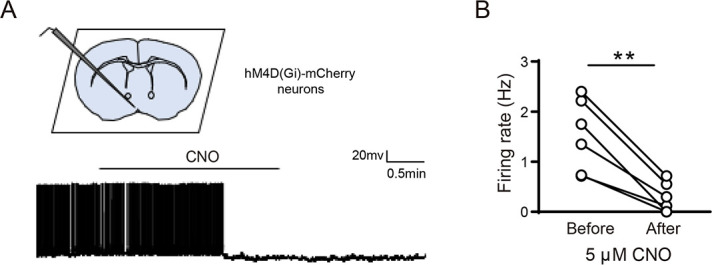
Inhibition of GnRH neurons expressing hM4D(Gi) by CNO.(A) Schematic of the acute brain slice and representative cell-attached recording showing the effect of 5 mM clozapine-N-oxide (CNO) on the firing rate of a GnRH neuron expressing hM4D(Gi)-mCherry. (B) Mean firing rate of six GnRH neurons (from 3 mice) before and after applying 5 mM CNO. ** p<0.01, paired t-test.